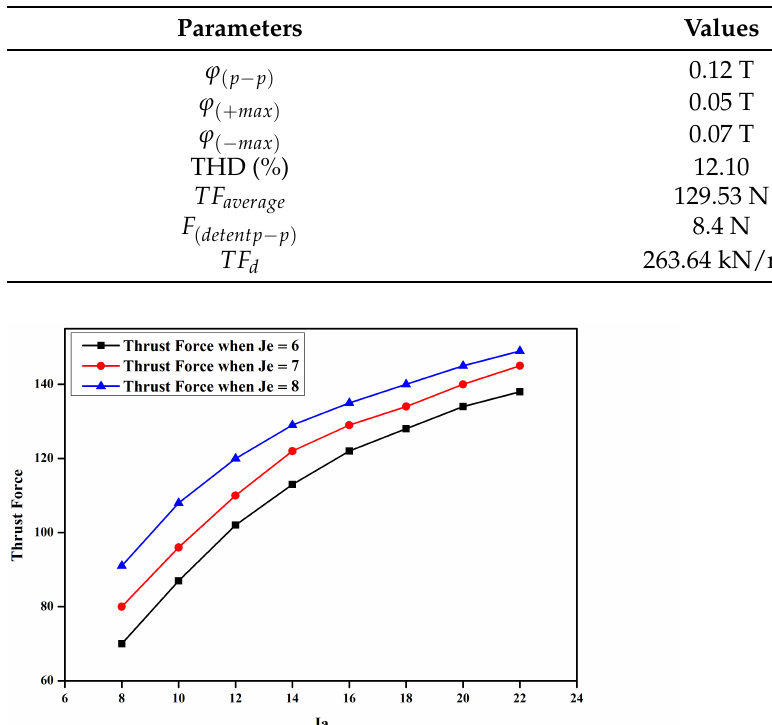
Table 6. Performance indicators.